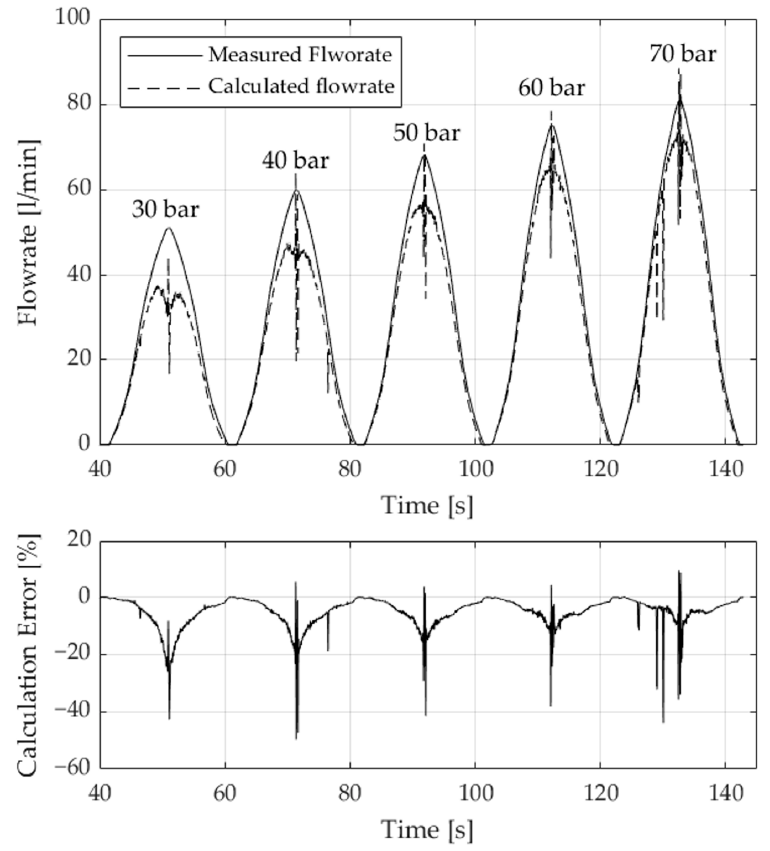
Figure 10. Measured and Estimated Flow Rate while Opening and Closing the Valve at differential Pressure Levels of 30–70